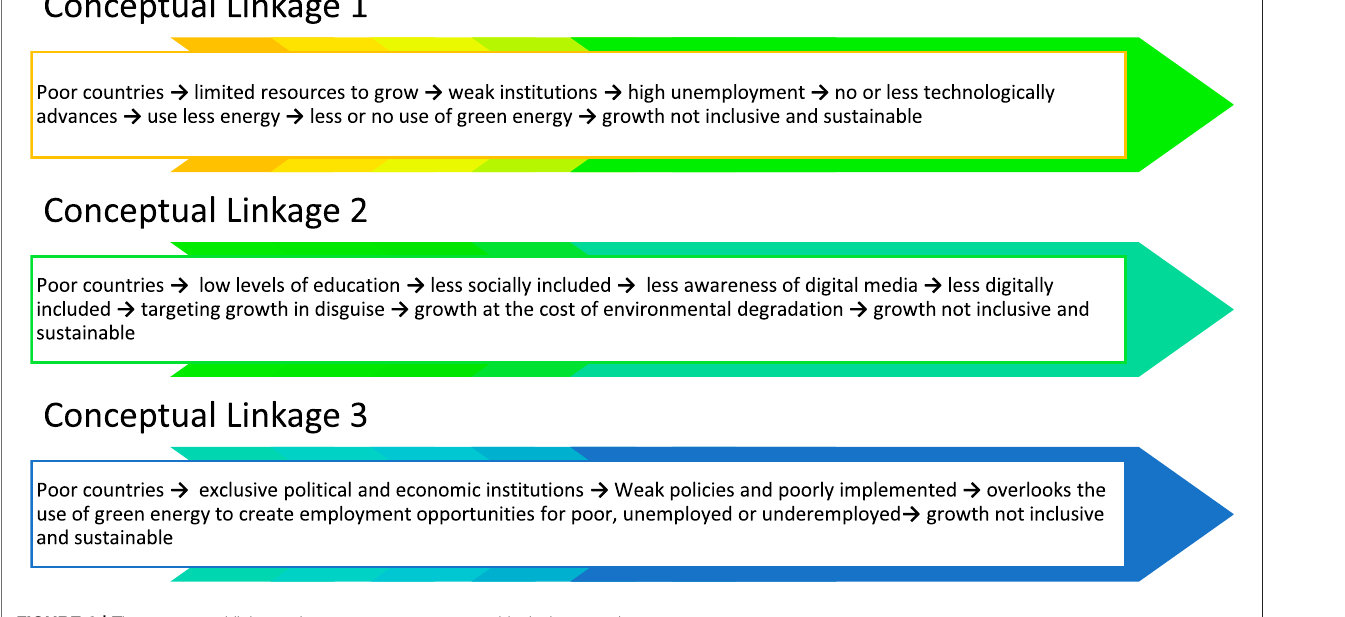
FIGURE 2 | The conceptual linkages between green energy and inclusive